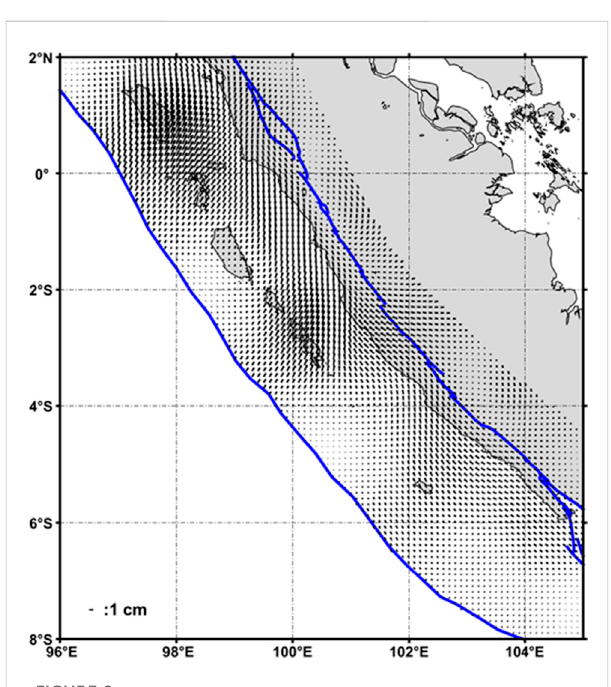
The pre-seismic GPS data model was derived based on Triyoso et al. (2020) and Triyoso et al.